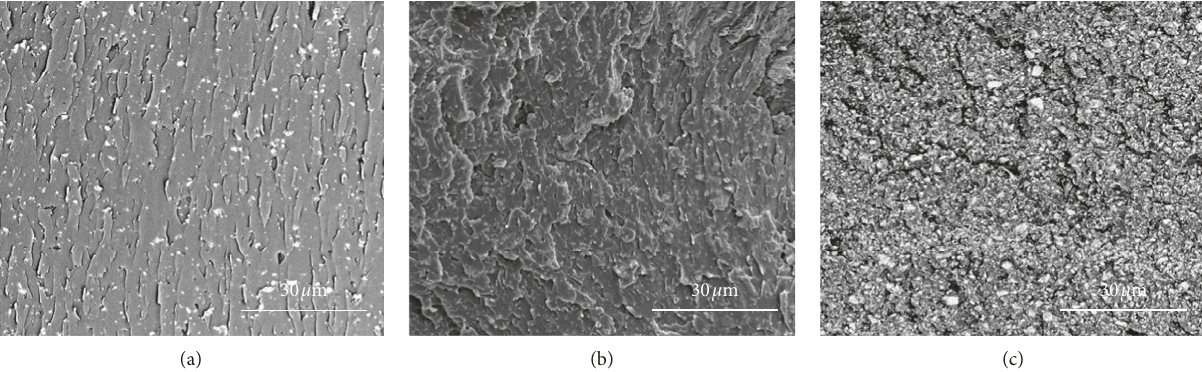
Figure 3: Fracture surface of PMN/EP composites at different contents of PMN: (a) 20wt.%, (b) 60wt.%, and (c) 80wt.%.